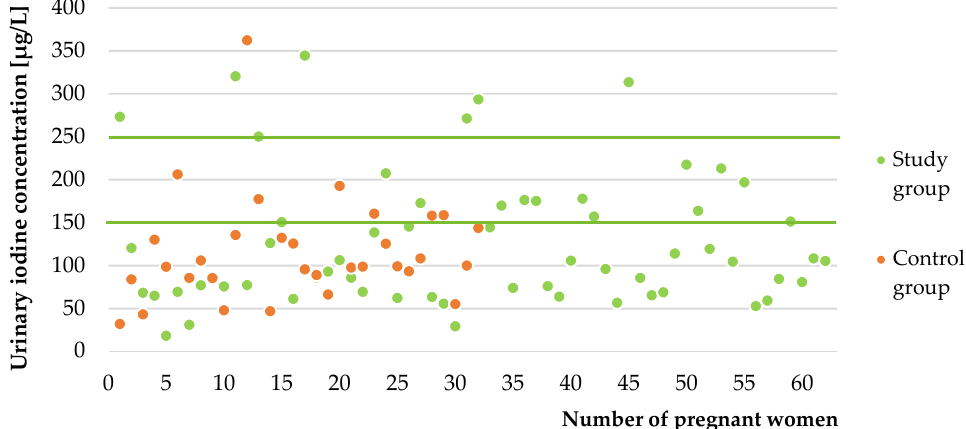
Figure 2. Urinary iodine concentrations in all pregnant women. The median UIC in all studied women was 127 µg/L (%CI: 110; 145). The median UIC in patients with iodine supplementation (133 µg/L, %CI: 109; 157) was higher than in those who were not taking iodine-containing supplements (117 µg/L, %CI: 95; 138), but the